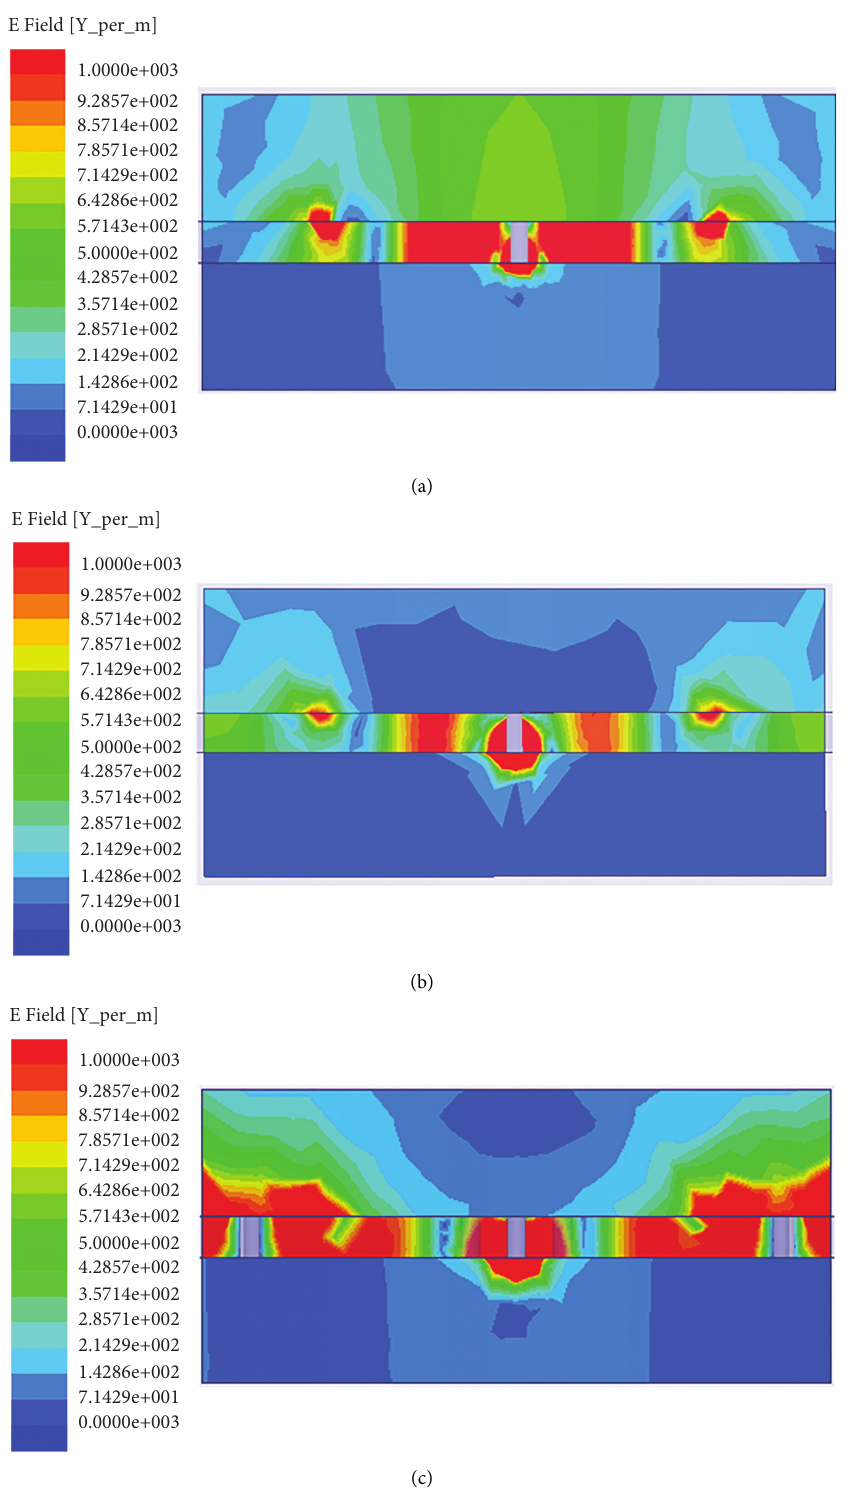
Figure 9: The electric field distribution of the antenna at 6.7 GHz in xoz plane. (a) Only with smaller circular patch, (b) with smaller circular patch and annular ring, and (c) the proposed